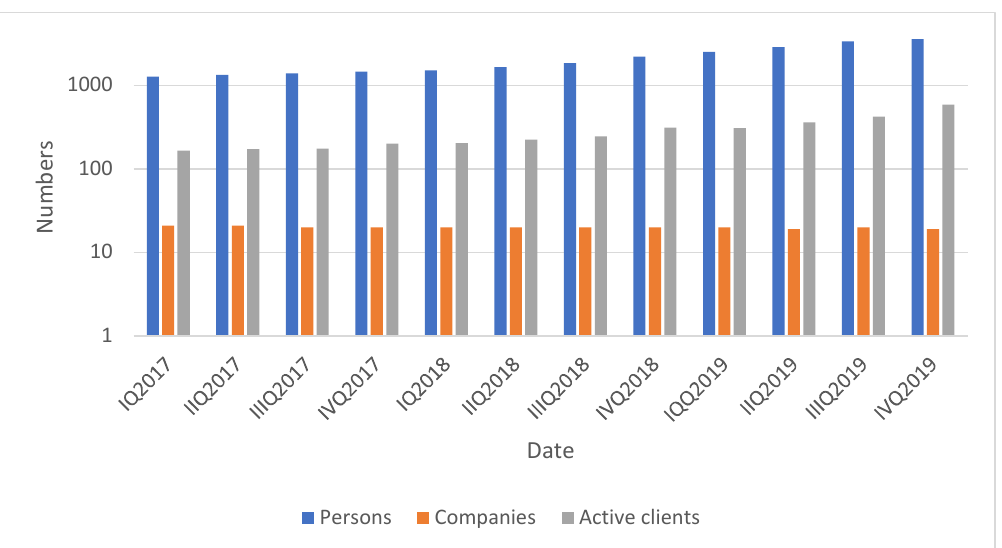
Figure 5. Clients’ dynamics in open innovation brokers in 2017–2019.